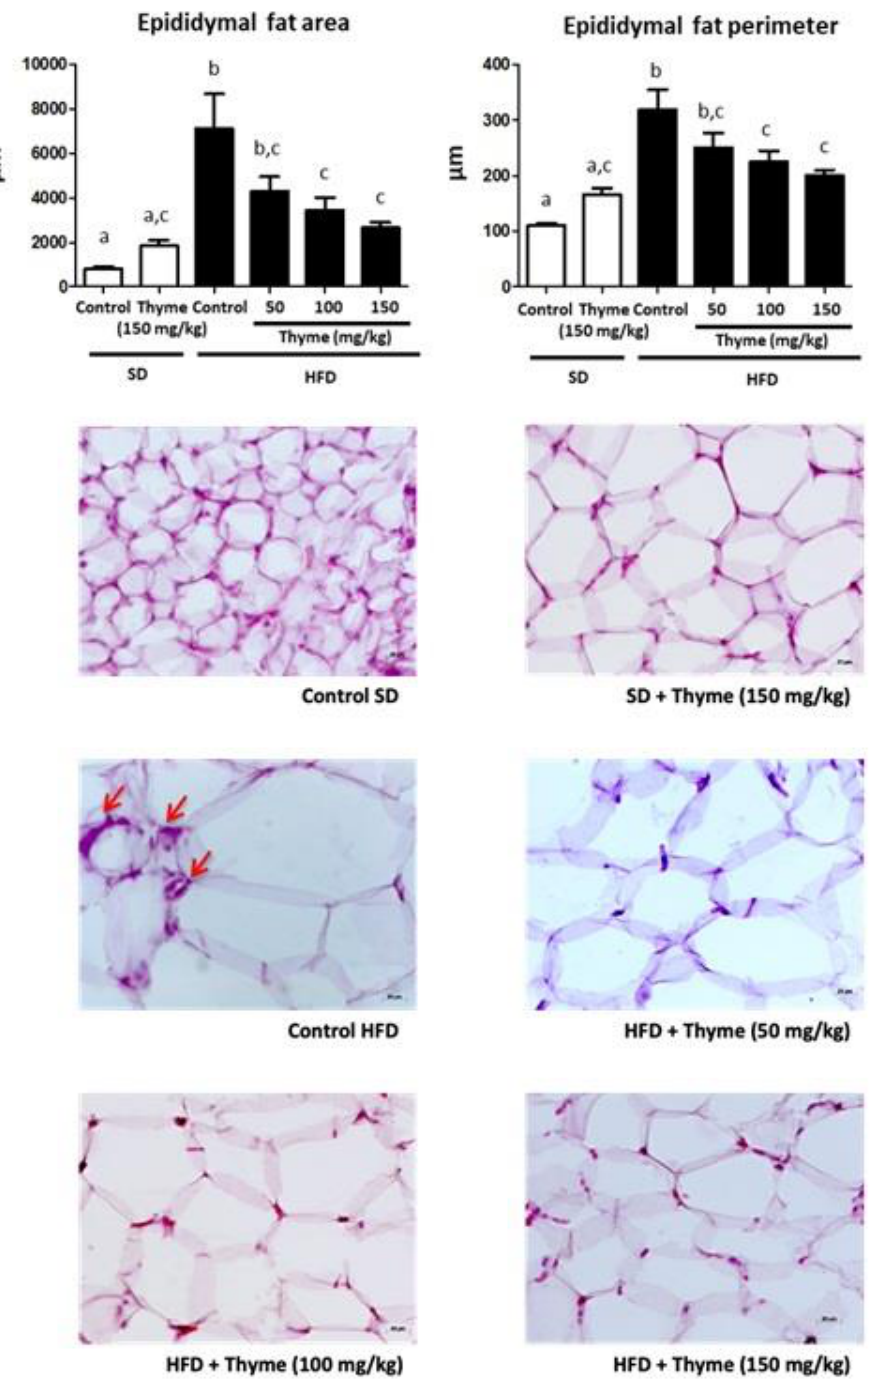
Figure 3. Effects of Thyme extract administration on epididymal adipose tissue, analyzed by hema- toxylin and eosin staining (scale bar = 20 µ m) and on area/perimeter of epididymal adipocytes. Data are expressed as means ± SEM ( n = 10). Groups with different letters statistically differ ( p < 0.05). Red arrows show mononuclear inflammatory aggregation.